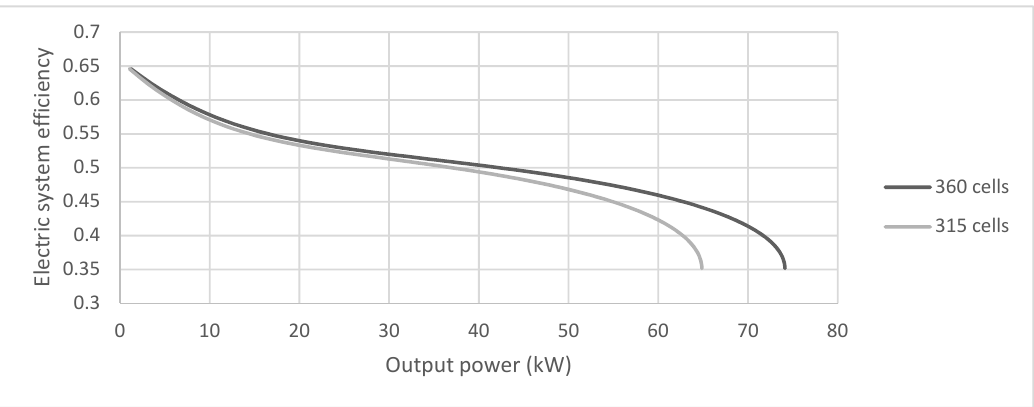
Figure 8. Impact of the number of cells on the stack electric efficiency (operating at two bar).